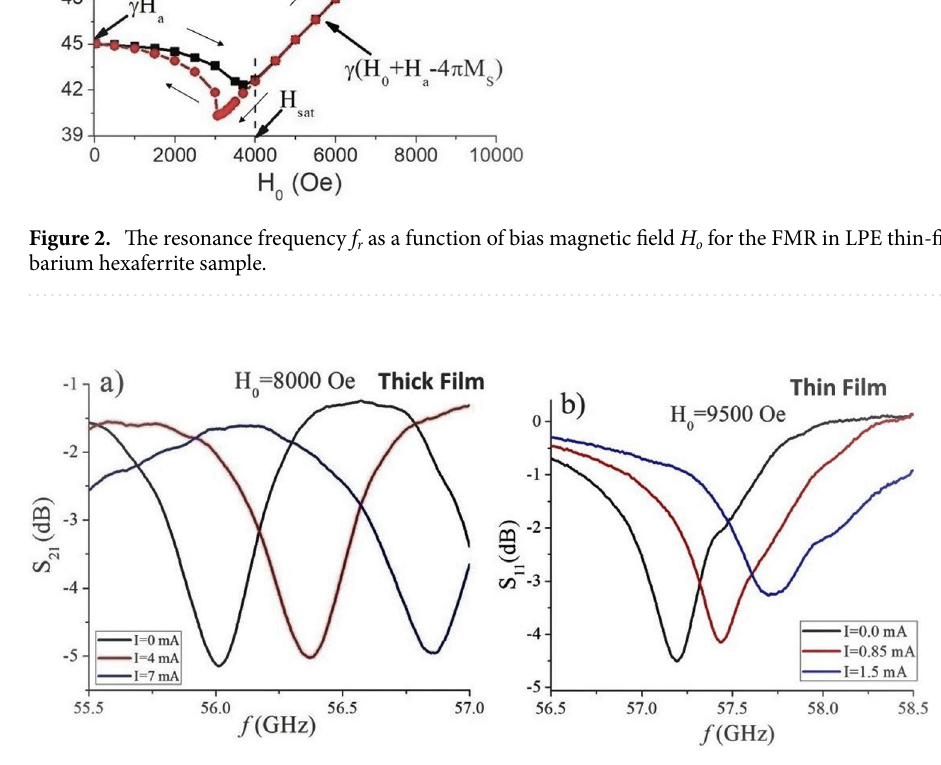
Figure 3. ( a ) Profiles of transmission coefficient as a function of f showing FMR in BaFe 12 O 19 single crystal platelet and ( b ) data on variation of reflection coefficient with. f showing FMR in LPE film of BaM. The data are for single domain resonance for a series of pulsed DC electric